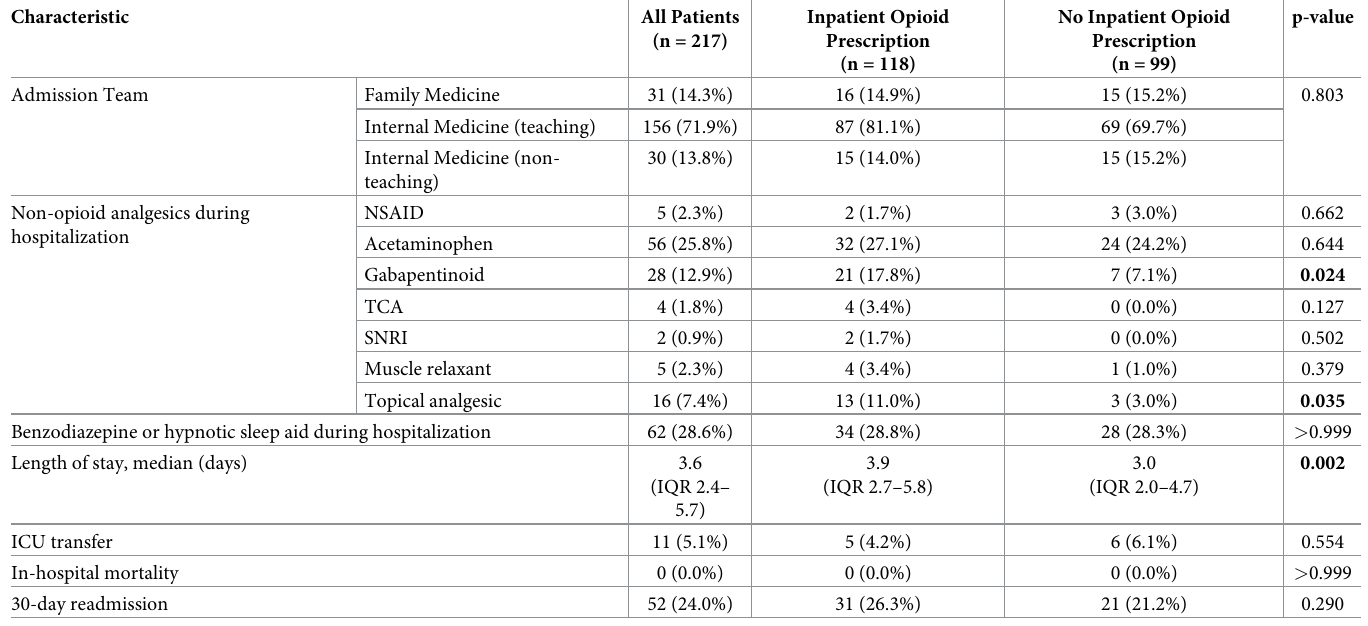
Table 3. Hospitalization characteristics.